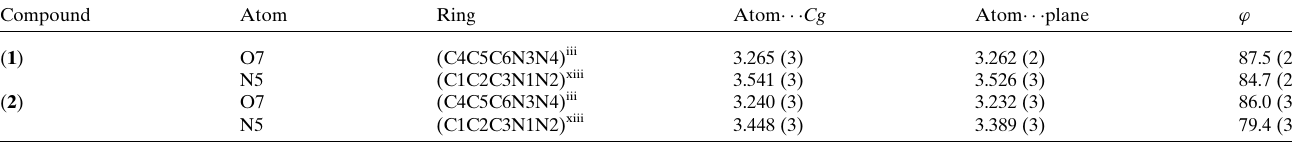
Table 4 Geometry of stacking interactions involving nitro and pyrazole groups (A˚ , (cid:5) ) in ( 1 ) and ( 2 ). Atom (cid:2)(cid:2)(cid:2) Cg is the shortest distance from the nitro group atom to the centroid of the ring; Atom (cid:2)(cid:2)(cid:2) plane is the deviation of the given atom from the mean plane of the ring and ’ is the angle of the atom (cid:2)(cid:2)(cid:2) Cg axis to the plane of the ring. Compound